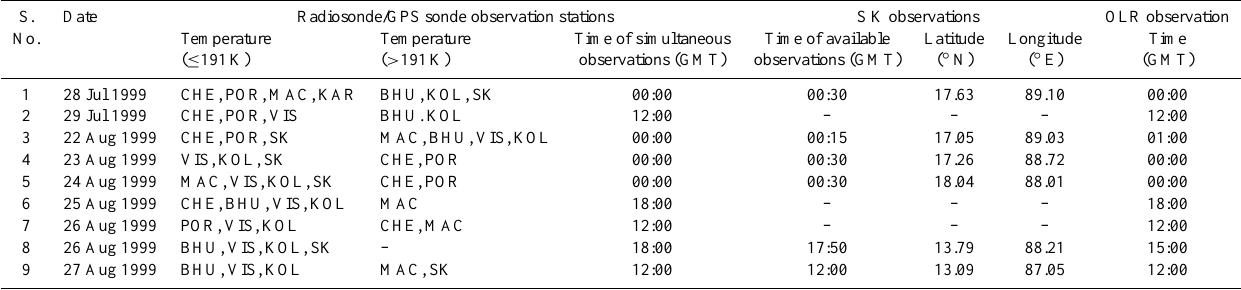
Table 1. List of date, time and stations for which CPT temperature ( T CPT ≤ 191K) is observed at three or more stations simultaneously. Stations for which T CPT > 191K are also listed.